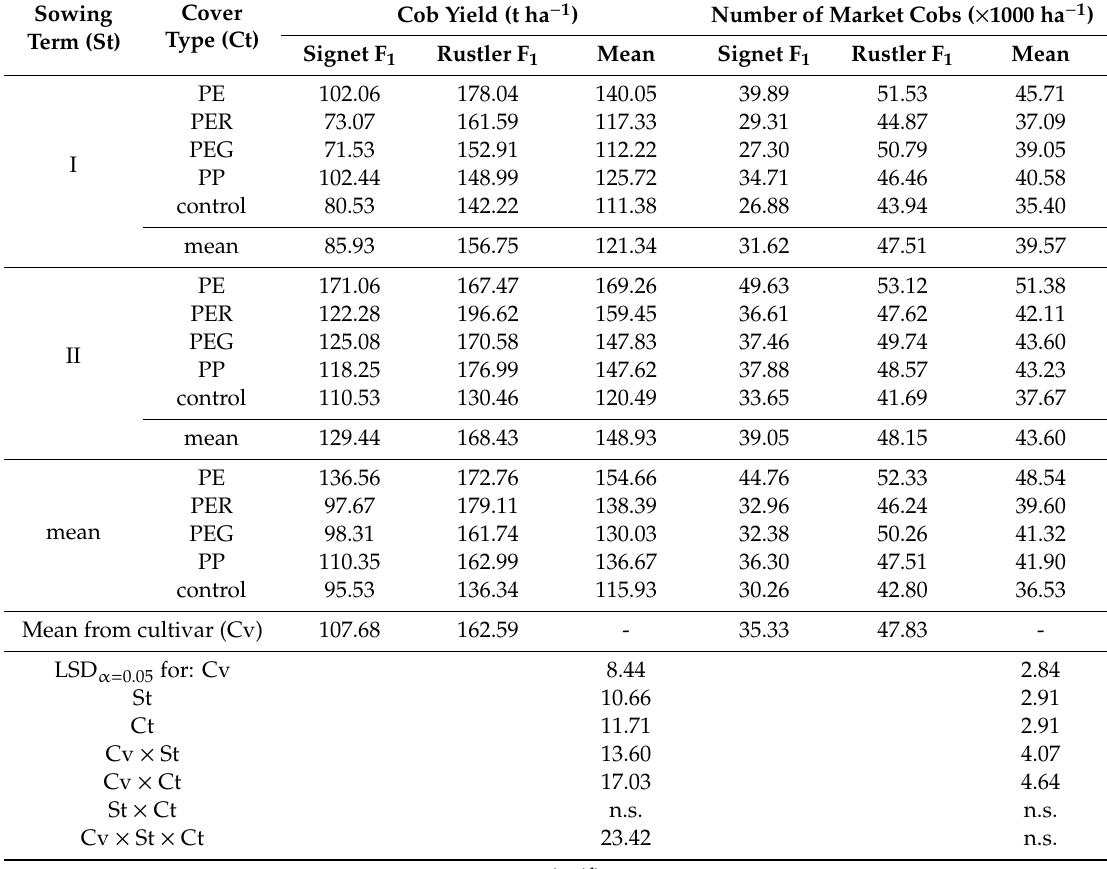
Table 6. The e ff ect of treatments on maize cob yield. Mean from the years